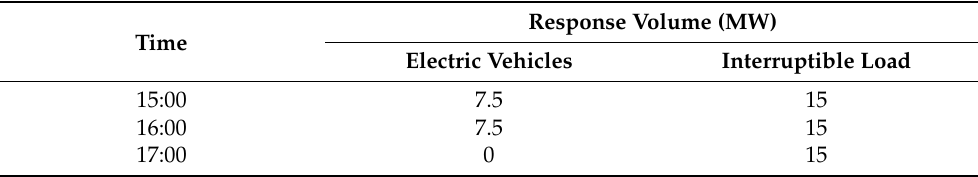
Table 9. Uncertain demand response